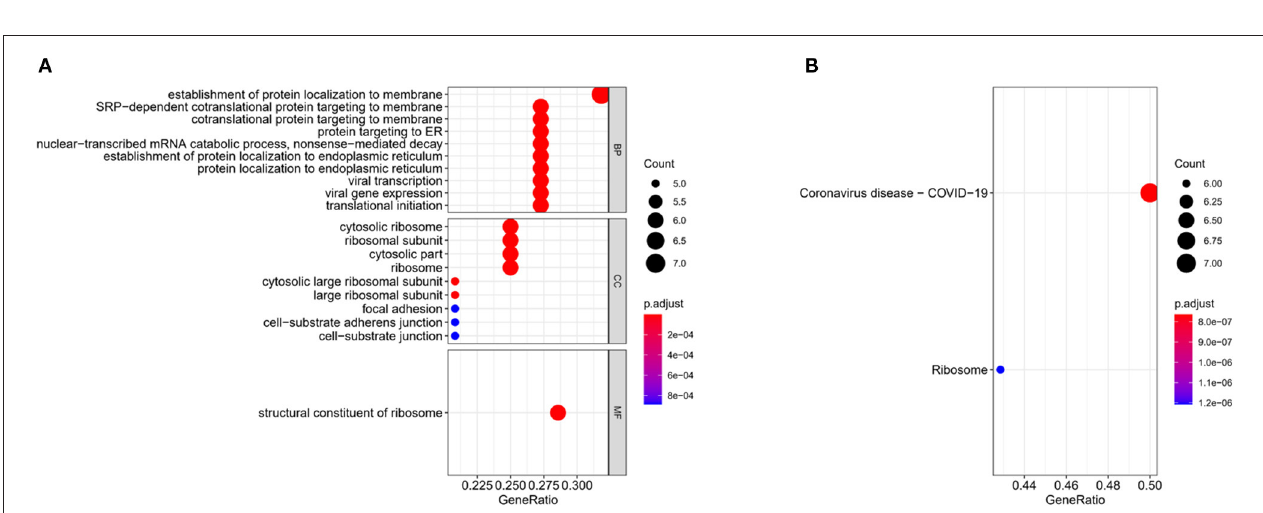
FIGURE 3 | Gene enrichment analyses. (A) Bubble plots for GO enrichment analysis of 24 feature genes. (B) Bubble plots for KEGG enrichment analysis of 24 feature genes. The bubble size in the figure indicates the gene data in teams, and the color indicates the p -value, and the red the color, the smaller the p